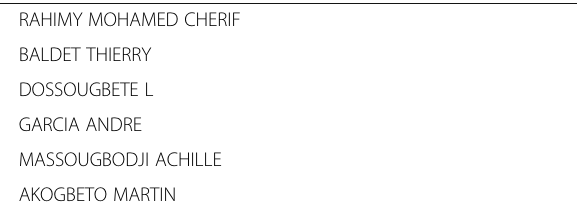
Table 1 List of the most important authors and collaborations